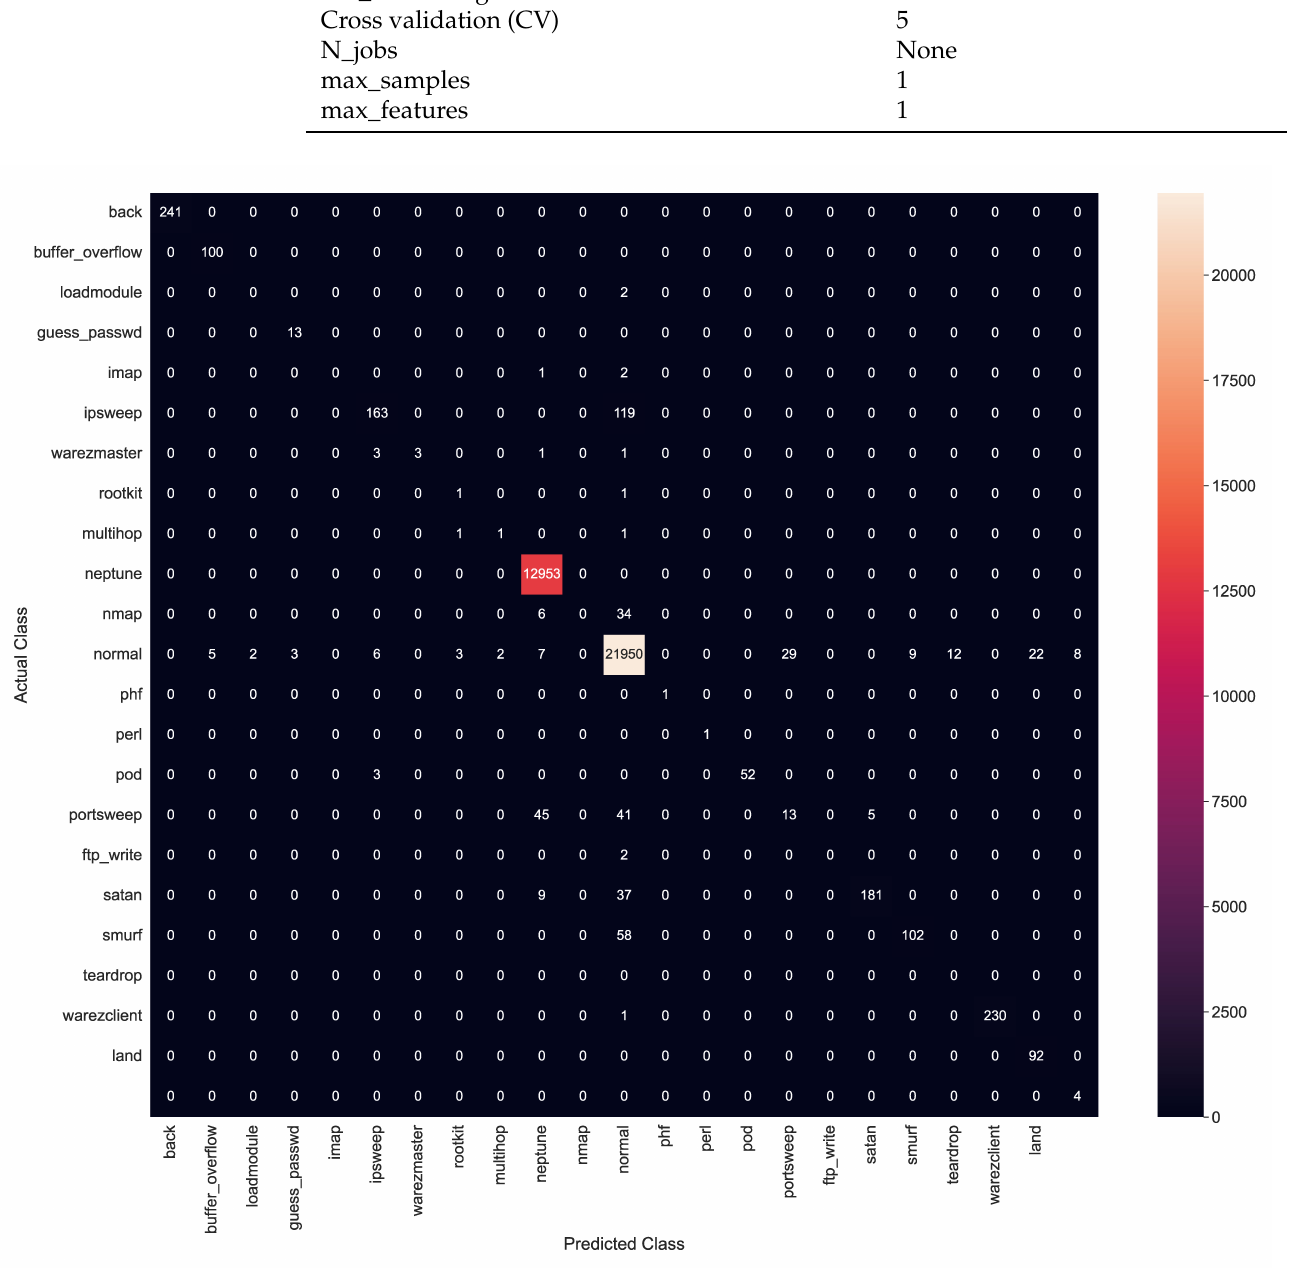
Figure 15. Confusion matrix for